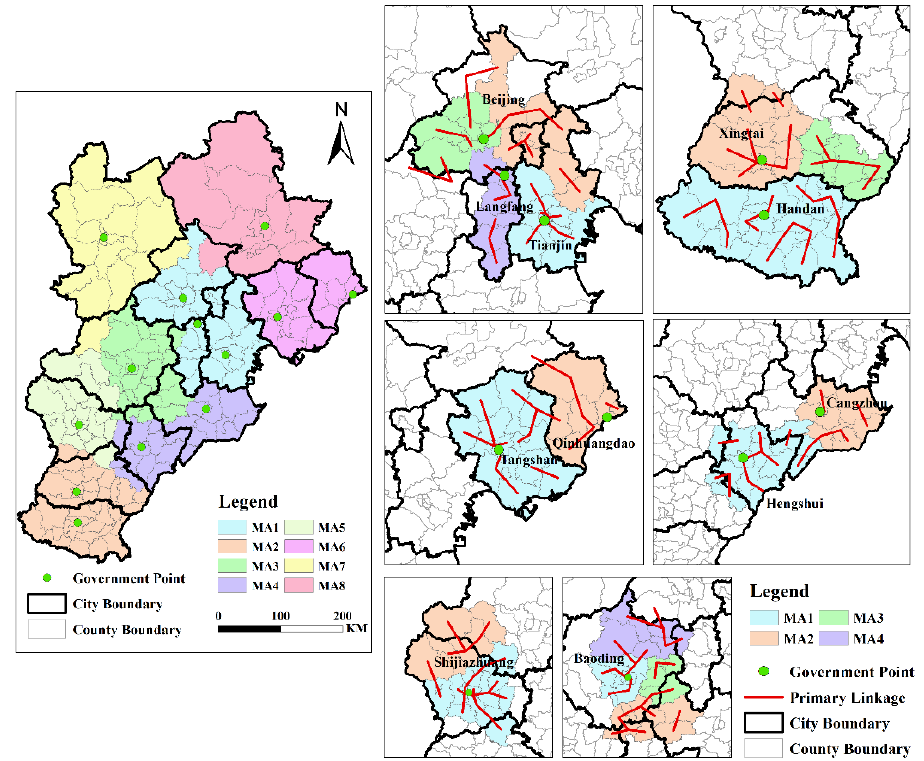
Figure 14. Coordinated development within each metropolitan area in the BTH